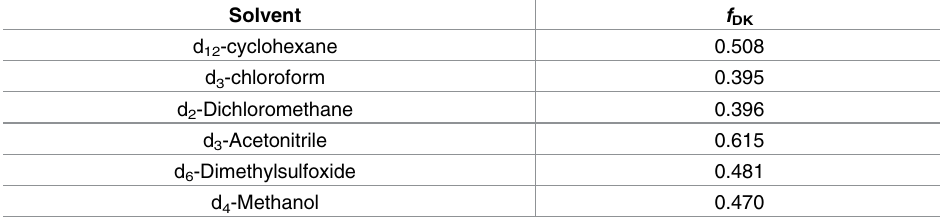
Table 3. NMR based assessment of K2T23 keto-enolic equilibrium.